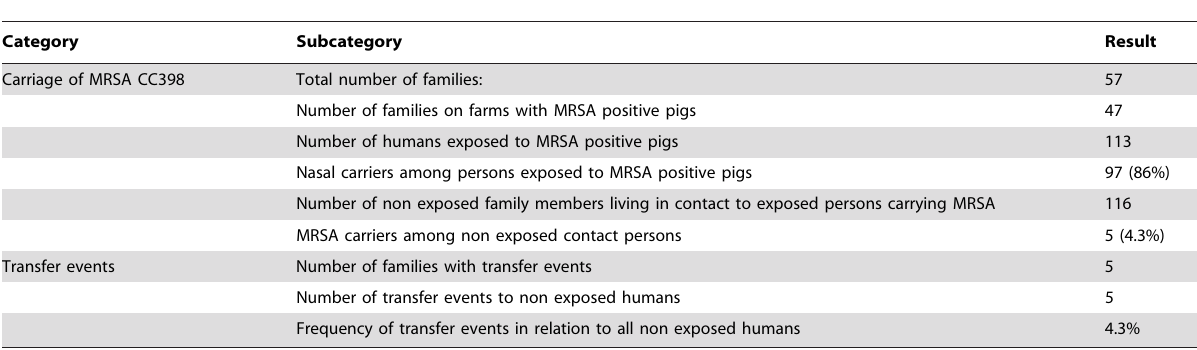
Table 1. Nasal carriage of MRSA CC398 among families living on pig farms.